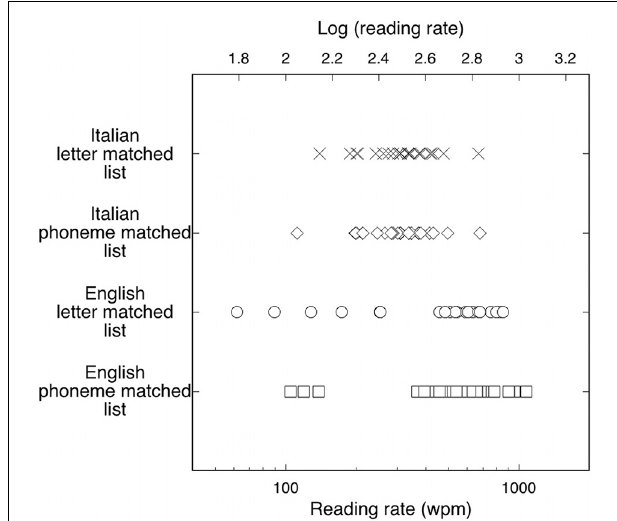
FIGURE 2 | Individual reading rates for Italian readers (Xs and diamonds for letter- and phoneme-matched lists, respectively) and English subjects (open circles and open squares for letter- and phoneme-matched lists, respectively). The upper scale shows the corresponding values expressed as a log (wpm). Reading rates for English observers are much more variable than rates for Italian